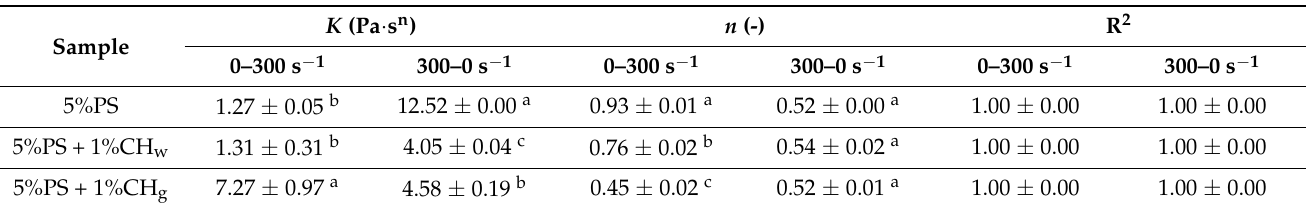
Table 3. Parameters of steady flow measurements (Ostwald–de Waele model) of 5% PS and its mixtures with 1% CH (whole and ground seeds).